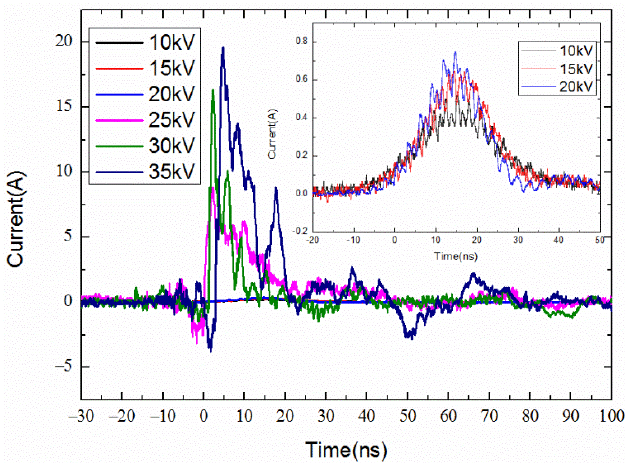
Figure 5. Output current waveforms under various bias voltages.